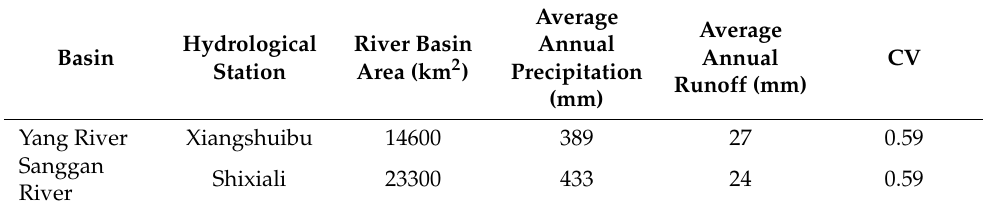
Table 1. Summary of main features of the two sub-basins in the UYRB.